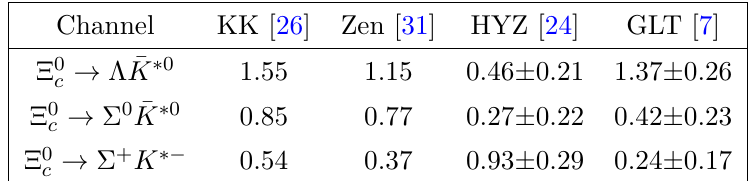
→ B n V decays based on the c